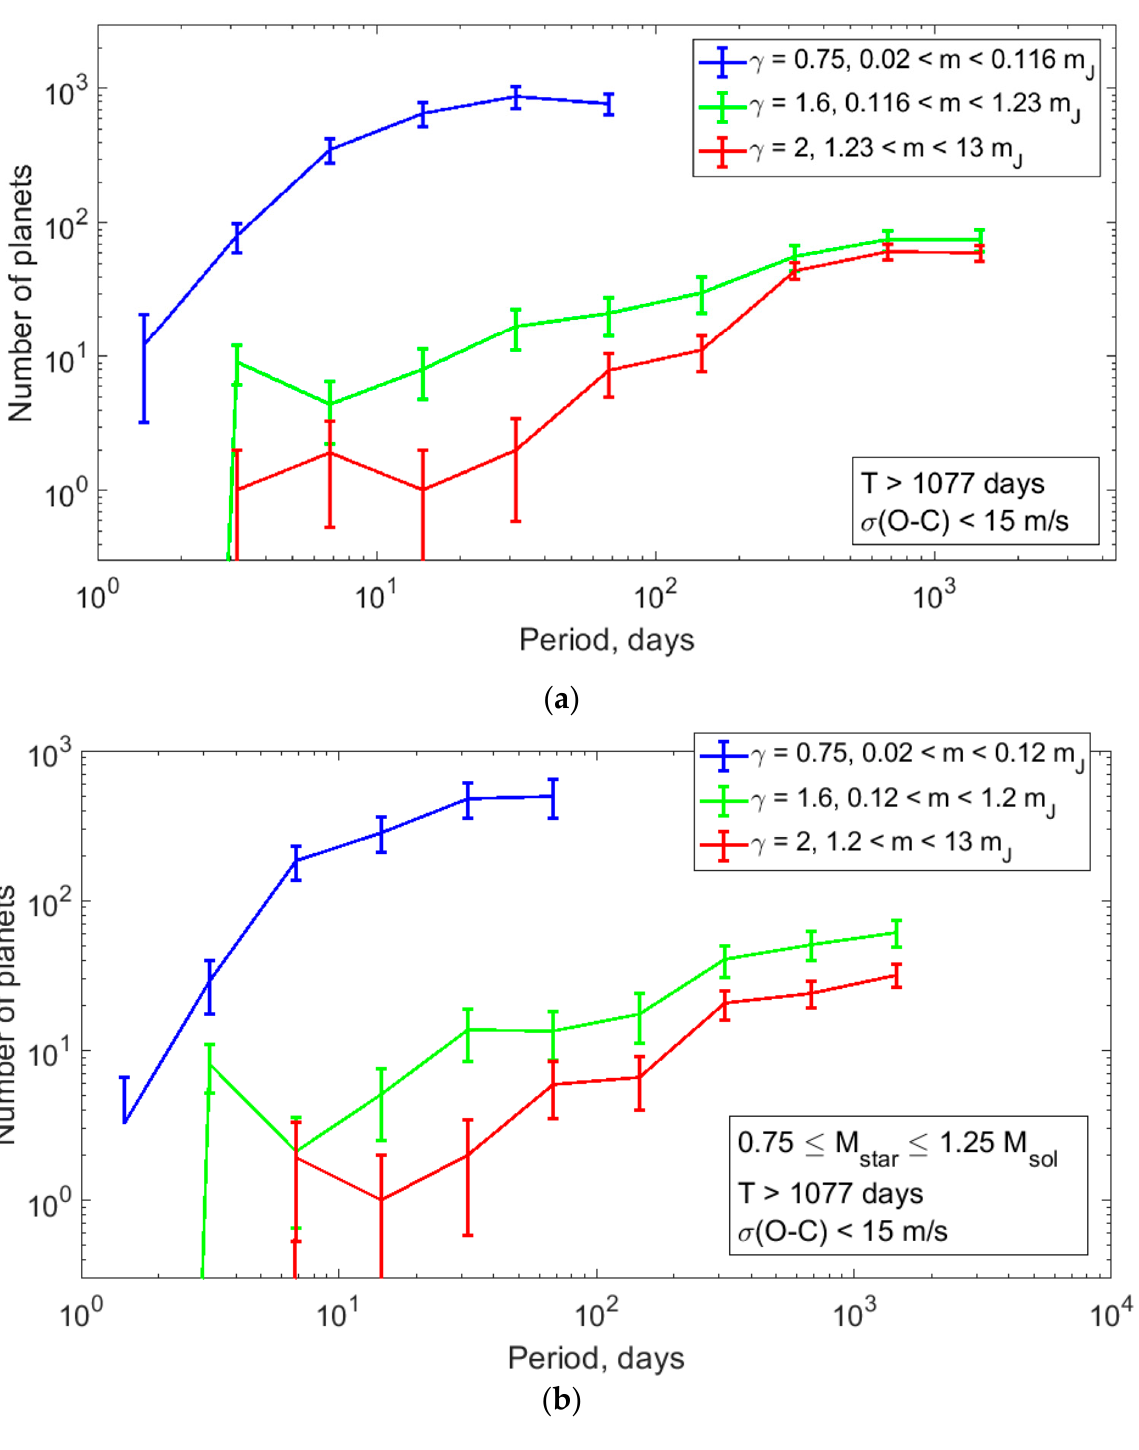
Figure 9. The de-biased orbital-period distributions for the planets from mass domains of (0.02–0.12) M J , (0.12–1.2) M J , and (1.2–13) M J are shown by blue, green, and red lines, respectively. Planets with a total observation time T > 1077 days in systems with a noise level σ (O − C) < 15 m/s are represented. ( a ) All types of host stars were considered, ( b ) FGK host stars were considered.